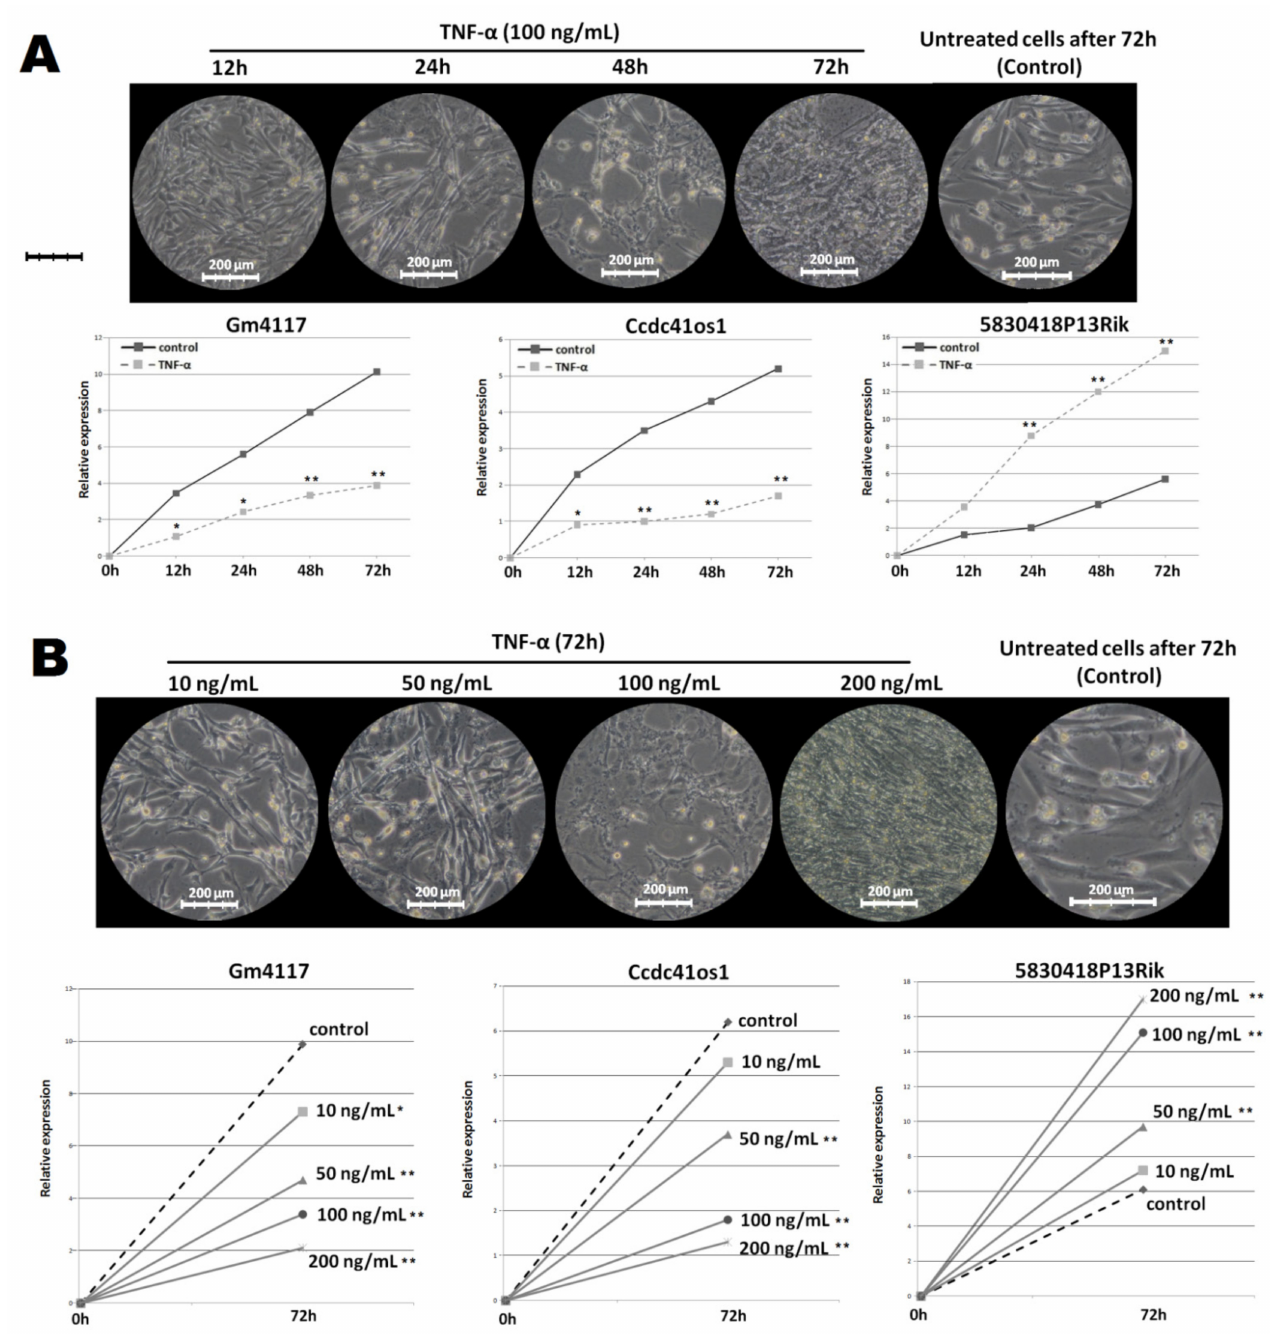
Figure 3. Dynamics changes in the expression of identified DElncRNAs under different TNF- α treatment conditions: ( A ) impact of 100 ng/mL TNF- α on myotube morphology within different treatment times (12, 24, 28, and 72 h) and corresponding dynamics changes in expression of DElncR- NAs; ( B ) changes in myotube morphology 72 h after treatment with different TNF- α concentrations (10, 50, 100, and 200 ng/mL) and corresponding differences in expression of DElncRNAs (* p < 0.05; ** p <